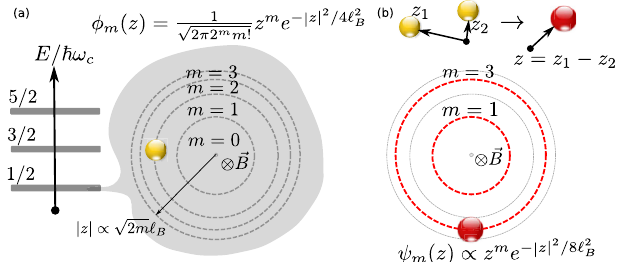
FIG. 1. (a) Landau levels and the single-particle states on the disk. The lowest LL is separated from the next lowest level by the cyclotron gap ℏ ω c . The wave functions of the LLL states are ϕ m , labeled by an integer m ¼ 0 ; 1 ; 2 … , and Gaussian localized along ffiffiffiffi p m l the ring of radius ∼ B . (b) Any two-particle state separates into a product of two wave functions, one depending on the center of mass and the other depending on the relative coordinate z ¼ z − z ψ 1 2 . The relative wave function m has an identical form to the single-particle wave function, with two important dif- ffiffiffi p 2 ferences: Its effective magnetic length is rescaled ( l B → l B ), and the integer value of m is constrained by particle statistics (assuming the spin is fully polarized); for fermions, the m ’ s entering the relative wave function are odd (red dashed